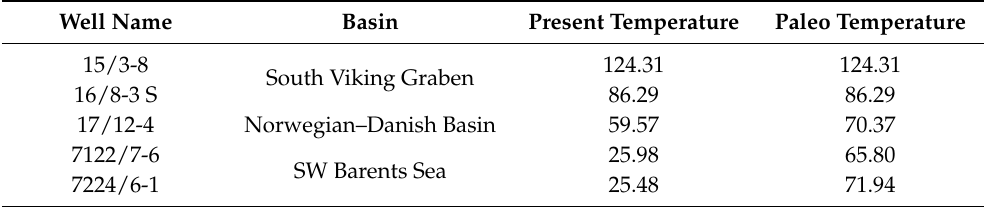
Table 4. The present and paleo temperatures of the studied wells on top of the upper